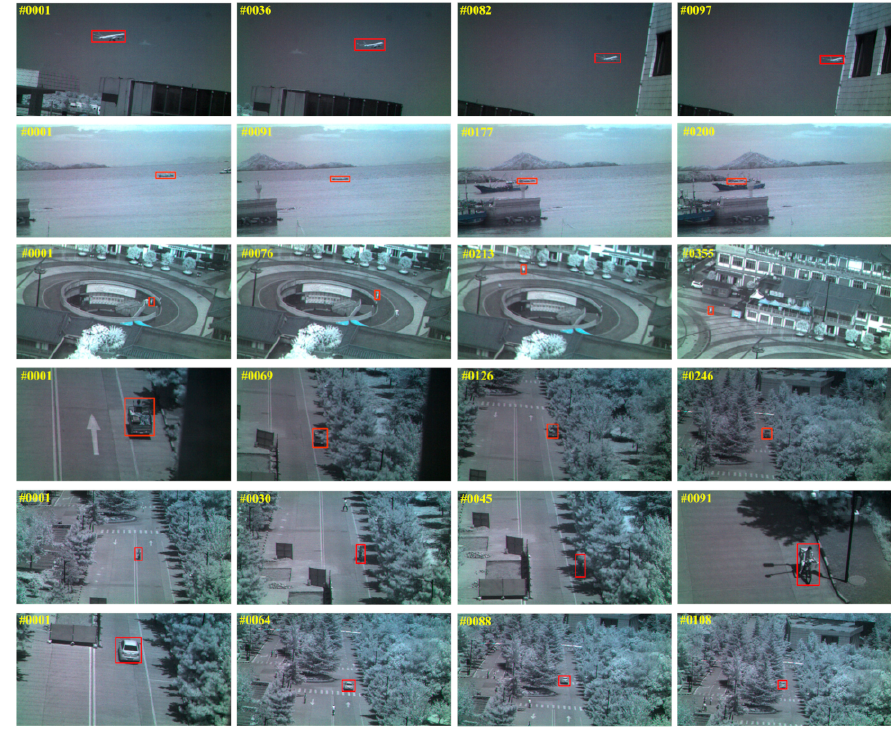
Figure 12. Example sequences with different tracking objects of the HSSV dataset. From top to bottom: airplane, boat, pedestrian, electric car, bicycle,